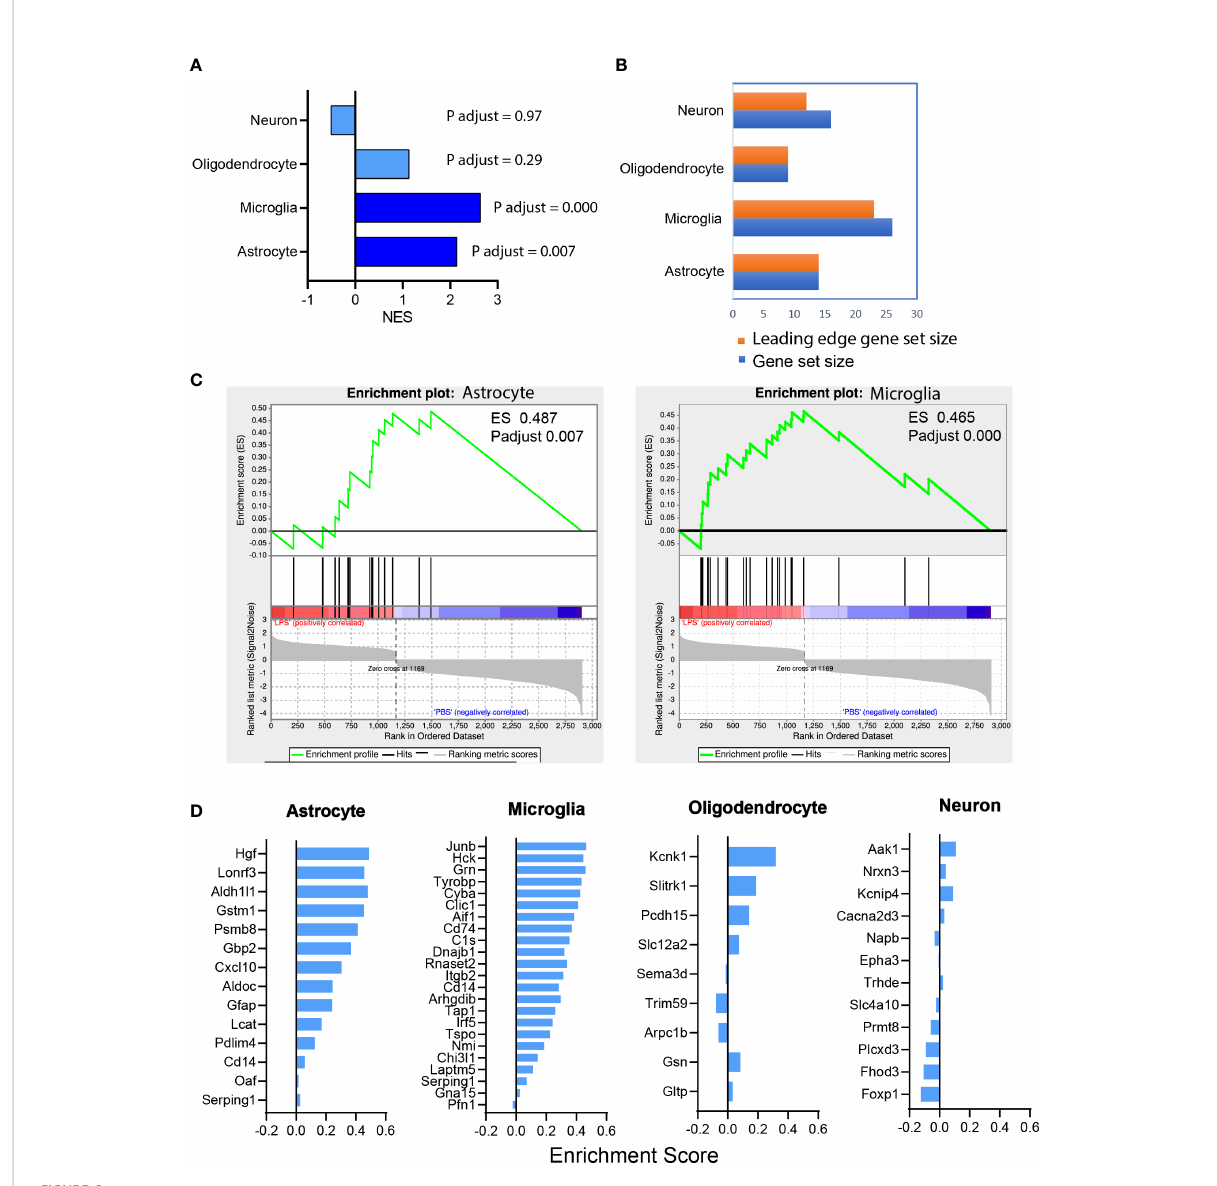
FIGURE 6 Astrocyte and microglia cell type-speci fi c enrichment was identi fi ed in the ONH transcriptome. (A) Gene set enrichment analysis (GSEA) was performed based on the differential expression gene list (sorting criteria: P adjust < 0.05, Fold change ≥ 1.0). The normalized enrichment scores (NES) of reference-based cell type-speci fi c gene sets in LPS vs PBS transcriptome are displayed. Astrocytic and microglial gene sets were signi fi cantly enriched (P adjust < 0.001) and matched genes showed upregulation in LPS group versus PBS group. (B) Counts of the gene sets that were matched in enrichment analysis. Orange, leading edge gene sets; blue, matched gene sets. (C) GSEA enrichment plots of astrocyte (ES 0.487, P adjust 0.007) and microglia (ES 0.465, P adjust 0.000) gene sets are shown. (D) The leading-edge gene sets for each cell type with the respective ES